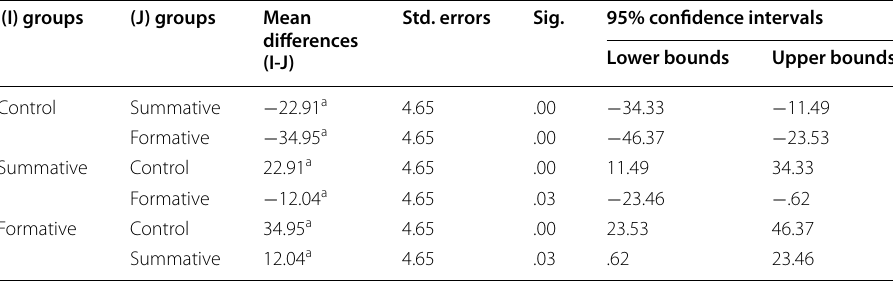
Table 15 Multiple comparisons by Bonferroni test (motivation)